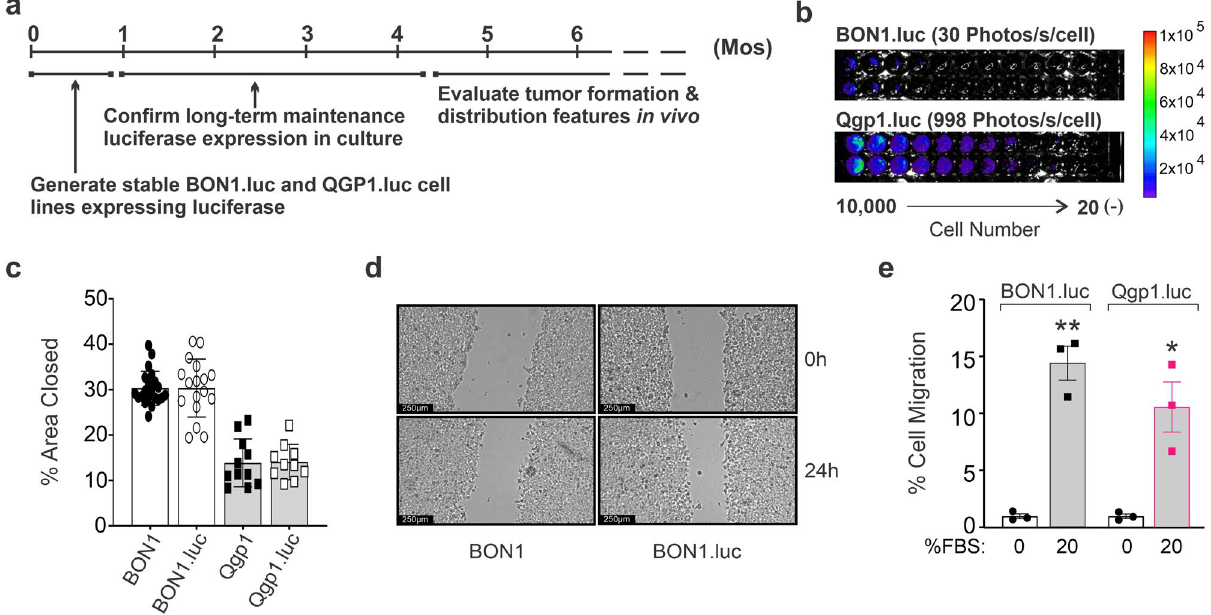
Figure 1. Development of bioluminescent pNEN cells and mouse models of metastasis. ( a ) Timeline showing initial generation of luciferase-expressing cell lines and time required to validate sustained bioluminescence and perform in vivo tumor studies. ( b ) In vitro assay of luciferase activity in serially diluted BON1.luc and Qgp1.luc cells following G418 selection. ( c ) Quantification of scratch assay migration data for parental cells and luciferase-expressing derivatives, as measured by the percent wound closure (% area closed) from 3 or more experiments, each with at least 3 replicates. Percent wound closure was measured using ImageJ version 1.8.0 freely downloaded from NIH (https:// imagej. nih. gov/ ij/ downl oad. html) ( d ) Representative images of the scratch assay in BON1 and BON1.luc cells at 0 and 24 h. ( e ) Transwell migration assay showing the fold increase in migration stimulated by 20% FBS relative to 0% FBS control. Samples were plated in triplicate and results replicated in at least three independent experiments. Representative data from one experiment are shown as mean ± SD; *, p = 0.05; **, p = 0.01; Welch t-tests with unequal variance comparing results between 0 and 20% FBS for each cell